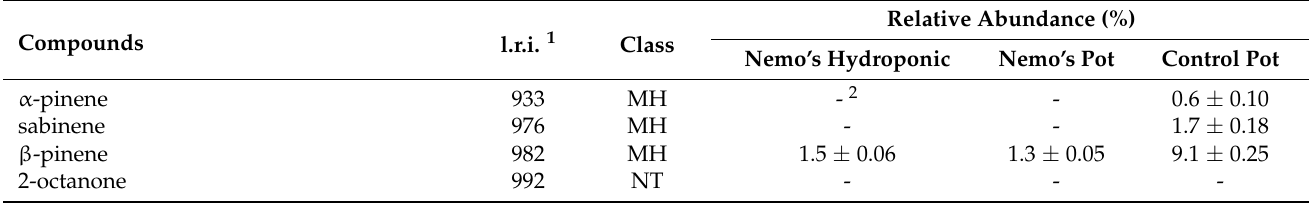
Table 4. Complete chemical composition of the headspace of the three analyzed samples of Stevia rebaudiana . The data are presented as relative abundance (%) ± standard deviation (SD, n =